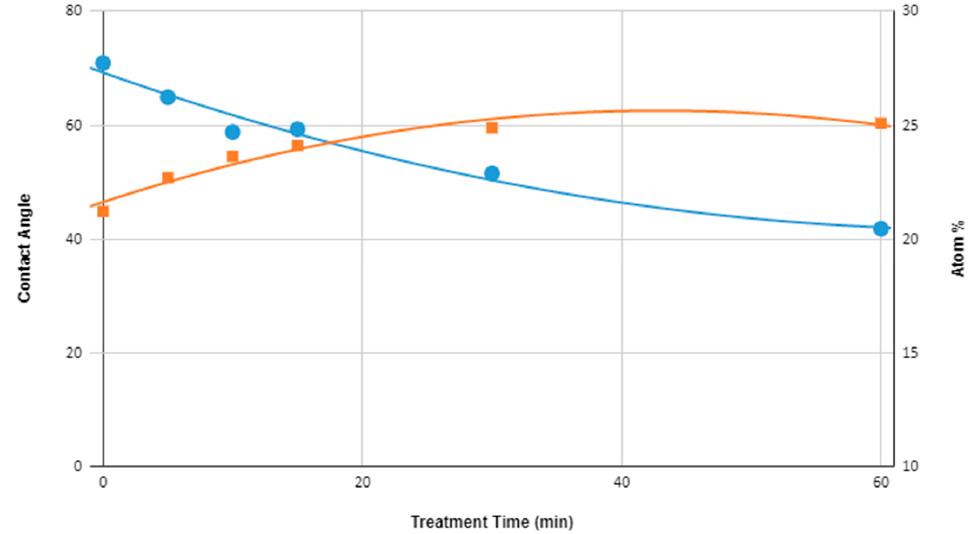
Figure 3. PES treated with VUV photo-oxidation showing an increase in atomic % of oxygen and a